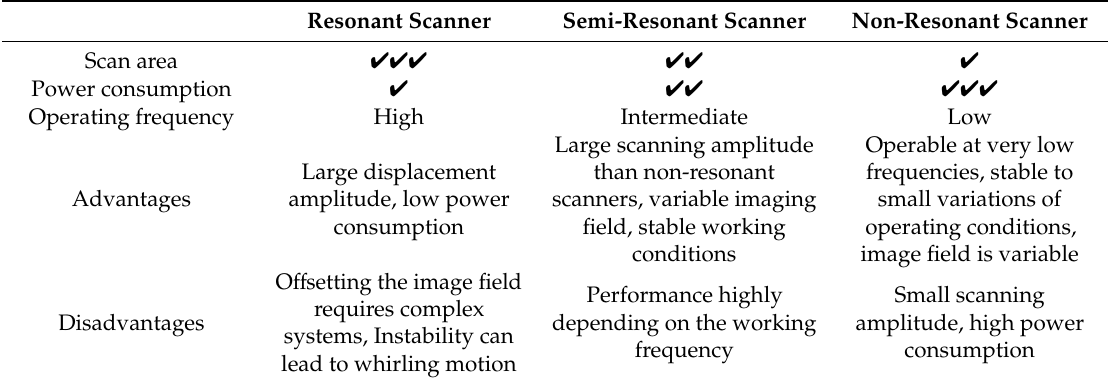
Table 3. Summary table for di ff erent